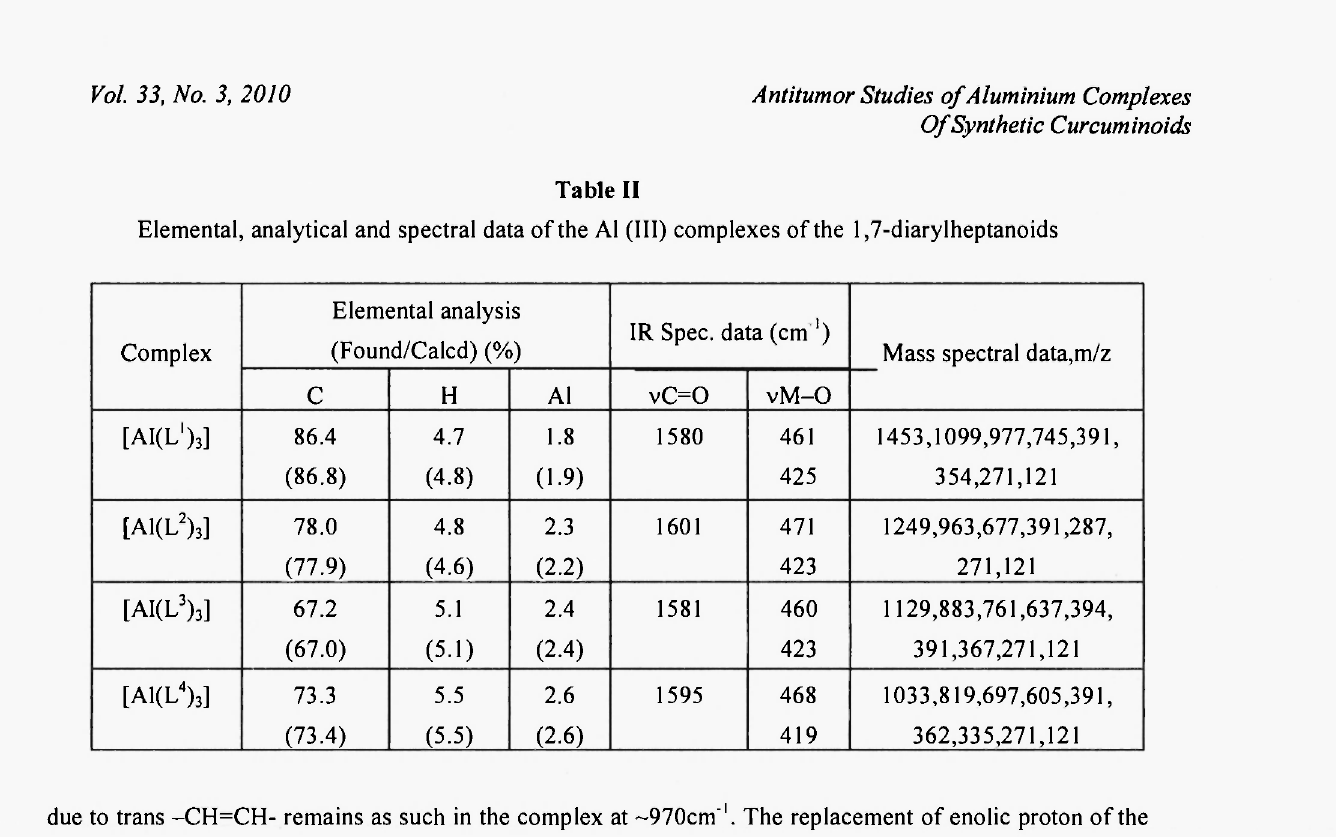
Elemental analysis